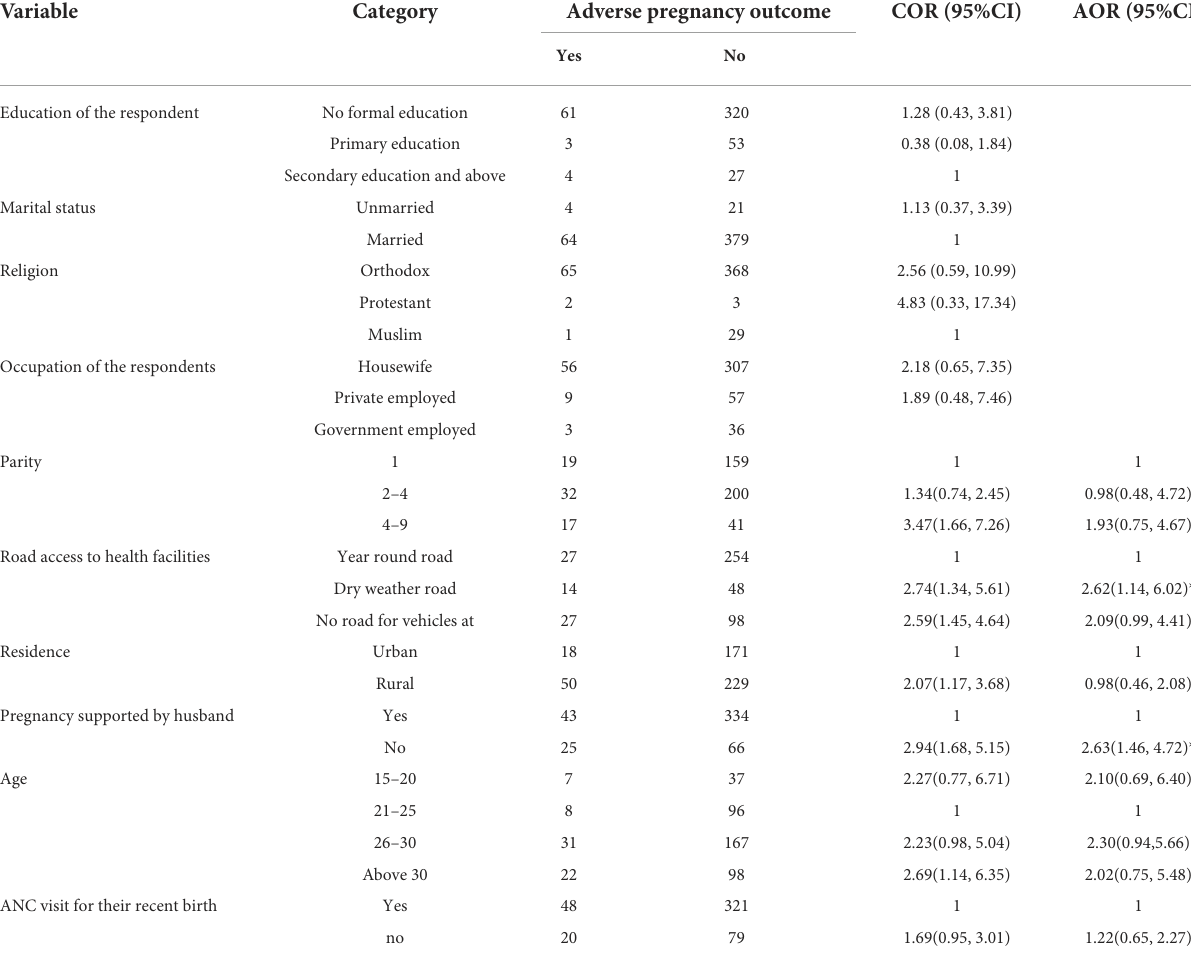
TABLE 4 Binary logistic regression analysis for factors associated with adverse pregnancy outcome, Northwest, Ethiopia, 2021( n = 468).